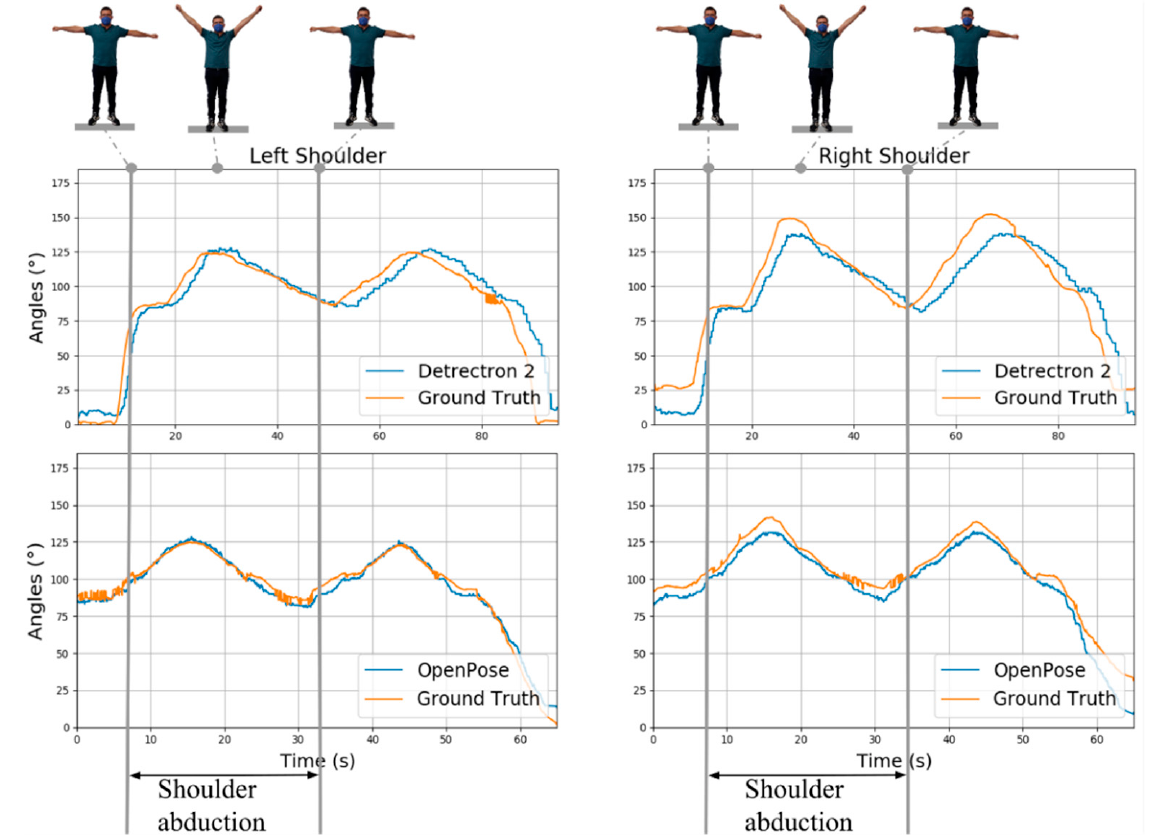
Figure 9. Exercise 4: Angles of both shoulders in shoulder abduction rehabilitation exercise for two